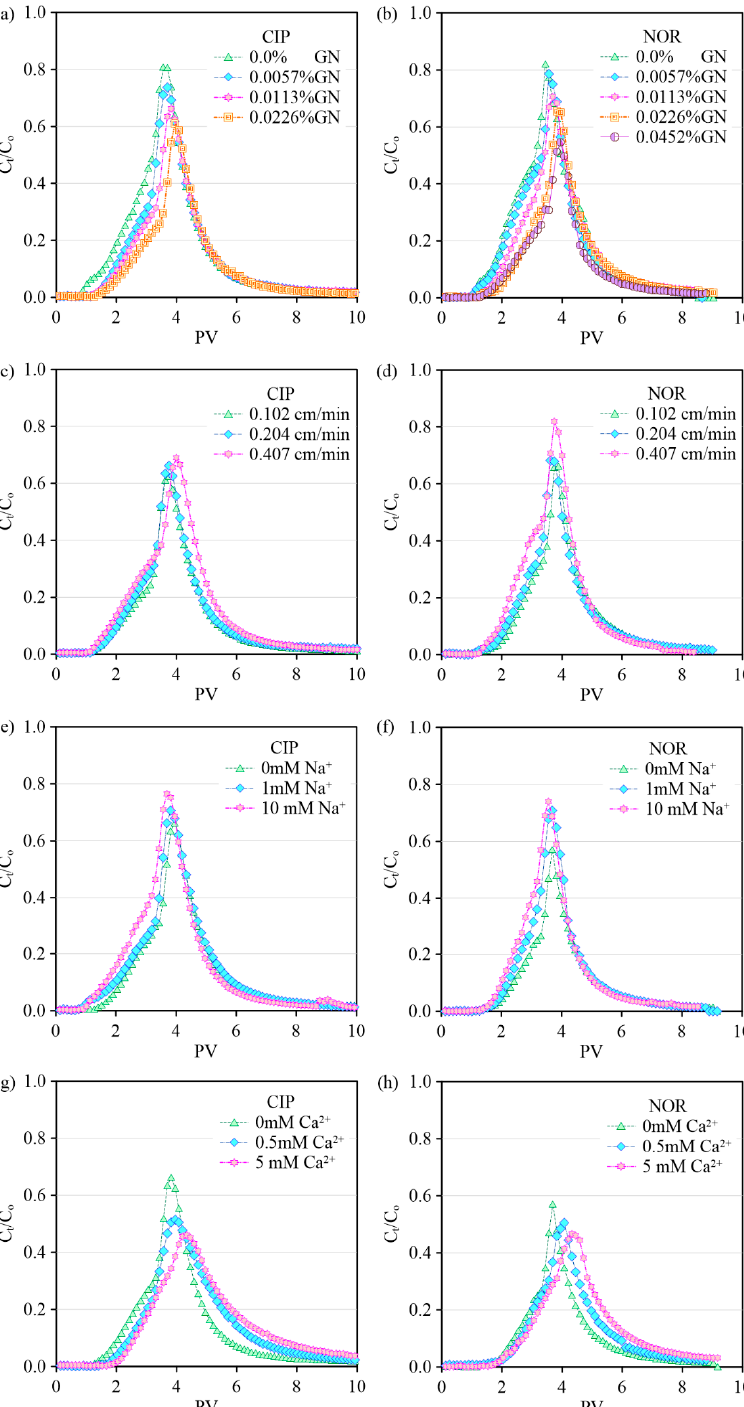
Figure 5. BTCs of CIP and NOR under different physicochemical conditions: ( a ) BTCs of CIP at different mass fractions of GN packed in column; ( b ) BTCs of NOR at different mass fractions of GN packed in column; ( c ) BTCs of CIP at different flow velocities; ( d ) BTCs of NOR at different flow velocities; ( e ) BTCs of CIP at different ionic strengths (Na + ); ( f ) BTCs of NOR at different ionic strengths (Na + ); ( g ) BTCs of CIP at different ionic strengths (Ca 2+ ); ( h ) BTCs of NOR at different ionic strengths (Ca 2+